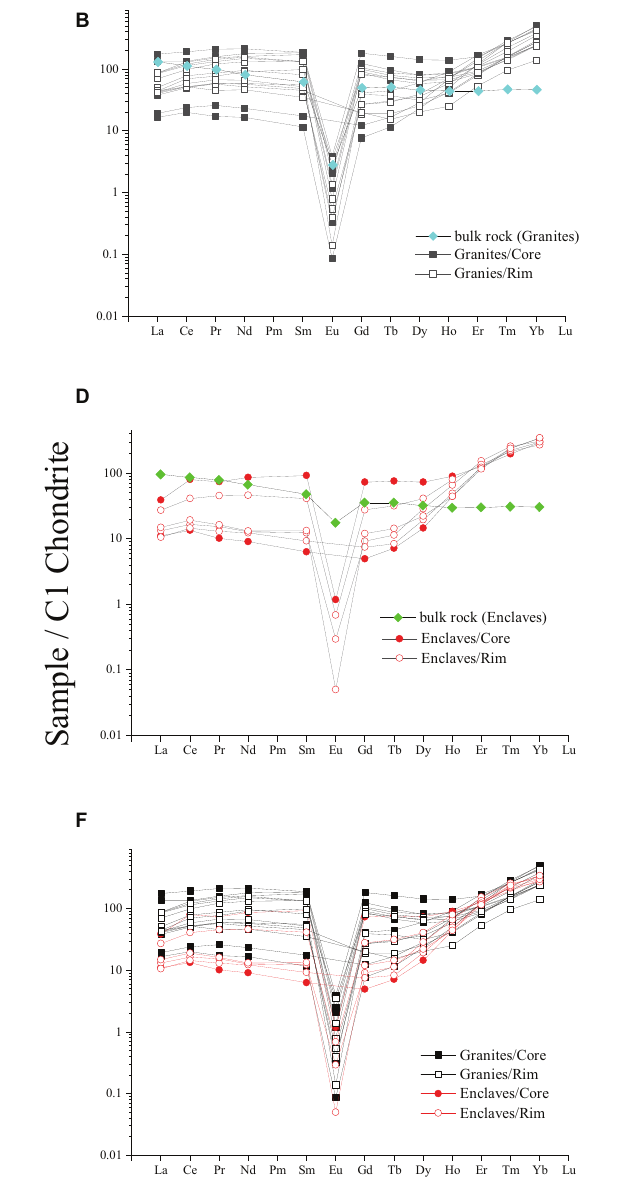
FIGURE 5 | Chondrite-normalized REE and primitive mantle-normalized trace element profiles of the amphiboles from gantries and MMEs and average bulk rock profiles of the hosts. (A) REE and (B) trace element spider diagram for the granites and their amphiboles; (C) REE and (D) trace element spider diagram for the MMEs and their amphiboles; (E) REE and (F) trace element spider diagram show contrasting between amphiboles of granites and MMEs and between cores and rims of amphiboles. The chondrite values and primitive values are from Sun and McDonough